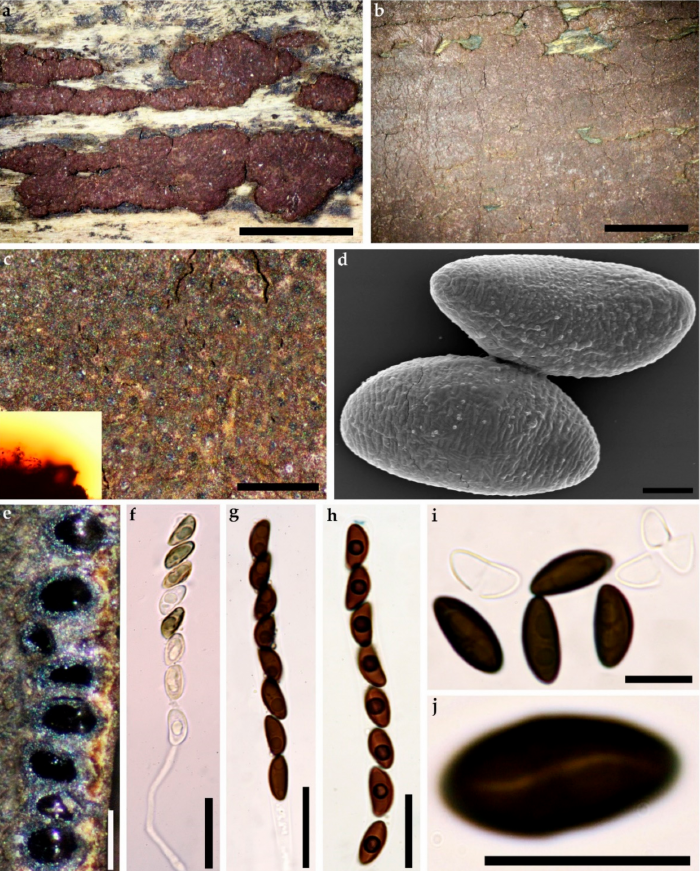
Figure 2. Hypoxylon eurasiaticum (Holotype GUM 1597). ( a ) stromatal habit; ( b , c ) close-up view of stromatal surface, with stromatal pigments in 10% KOH; ( d ) ascospore under SEM; ( e ) stroma in section showing perithecia and ostioles; ( f ) immature ascus in water; ( g ) mature ascus in water; ( h ) ascus in Melzer’s reagent; ( i ) ascospores in 10% KOH with dehiscent perispore; ( j ) ascospore in water, with sigmoid germ-slit. Scales bars set as ( a , b ) 5 mm; ( c ) 0.5 mm; ( d ) 2 µ m; ( e ) 0.5 mm; ( f – h ) 20 µ m; ( i , j ) 10 µ